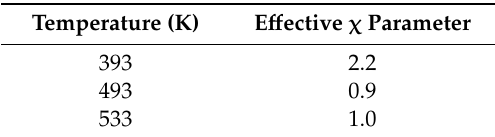
Figure 2. Schematic illustration of a coarse-grained model of PS- b -PI copolymer. Table 2. E ff ective Flory-Huggins segment–segment interaction parameters between distinct beads at di ff erent